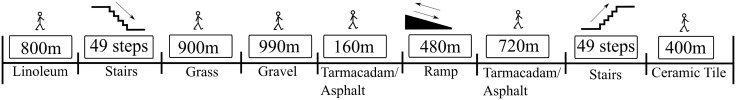
Prescribed walking route.Breakdown of surfaces and distances throughout the walking route.